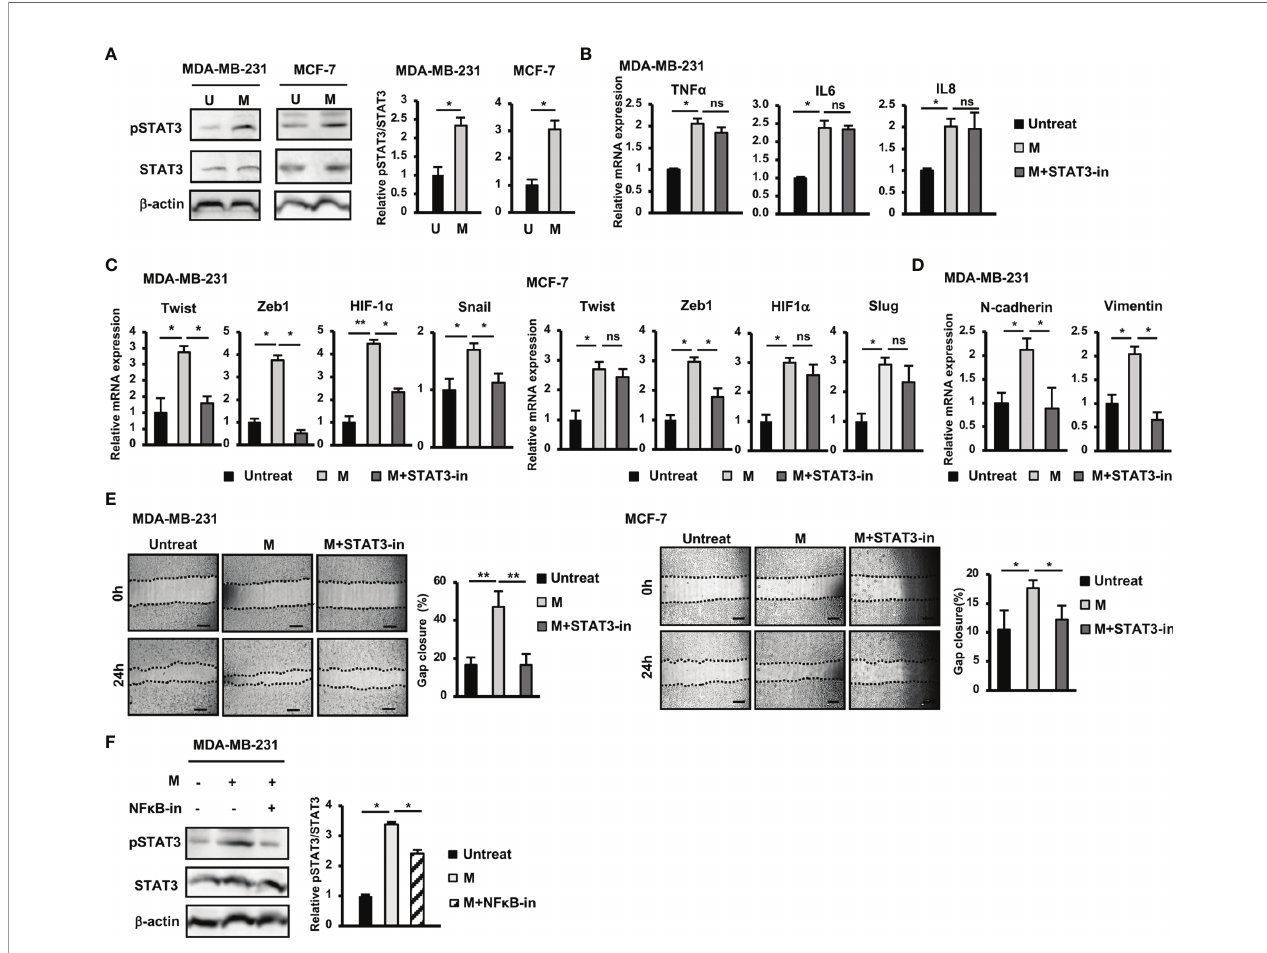
FIGURE 3 | Activation of STAT3 pathway contributed to the upregulation of EMT genes and the induction of migration of BCC by SARS-CoV-2 M protein. (A) The phosphorylation of STAT3 in BCC treated with M protein. (B) Gene expression of in fl ammatory cytokines in MDA-MB-231 cells treated with M protein in the presence of STAT3 inhibitor. (C) EMT-related gene expression in BCC treated with M protein in the presence of STAT3 inhibitor. (D) The mRNA expression of EMT markers in MDA-MB-231 cells treated with M protein in the presence of STAT3 inhibitor. (E) Migration of BCC treated with M protein in the presence of STAT3 inhibitor. (F) The phosphorylation of STAT3 in MDA-MB-231 in the presence of M protein and the NF k B inhibitor. Galiellalactone 100 ng/ml (SC-202165; Santa Cruz Biotechnology) was used as a STAT3 inhibitor. BAY11-7082 10 m M was used as an NF k B inhibitor. U, untreated BCC; M, M protein-induced BCC. The scale bars indicate 500 µm. Each value represents the mean ± SD of triplicate experiments. (ns, no signi fi cance; p > 0.05; *p ≤ 0.05; **p ≤